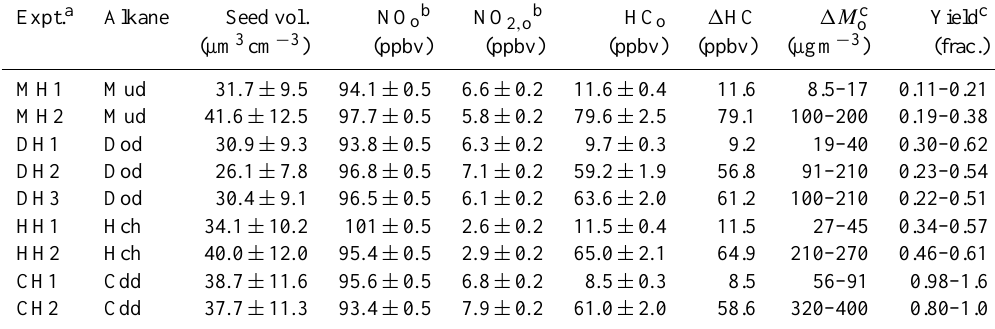
Table 2. High-NO x experimental